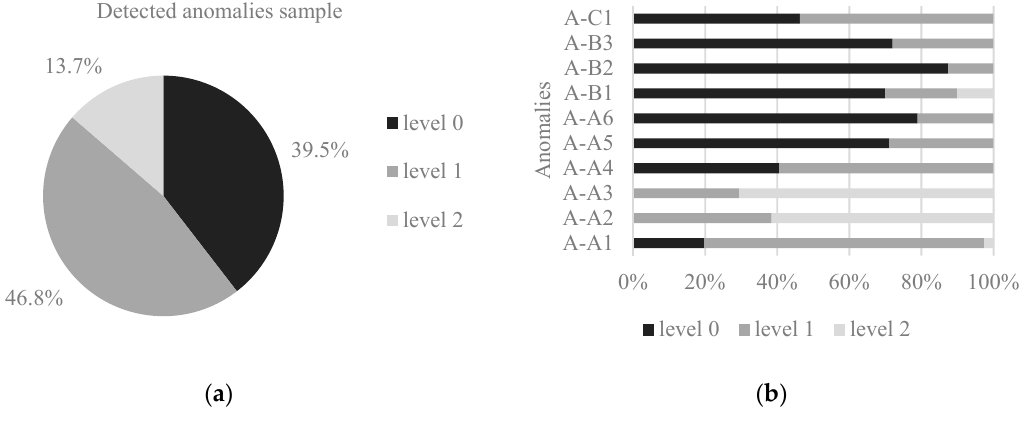
Figure 3. Urgency of repair: ( a ) Relative frequency of anomalies in each level; ( b ) relative frequency of